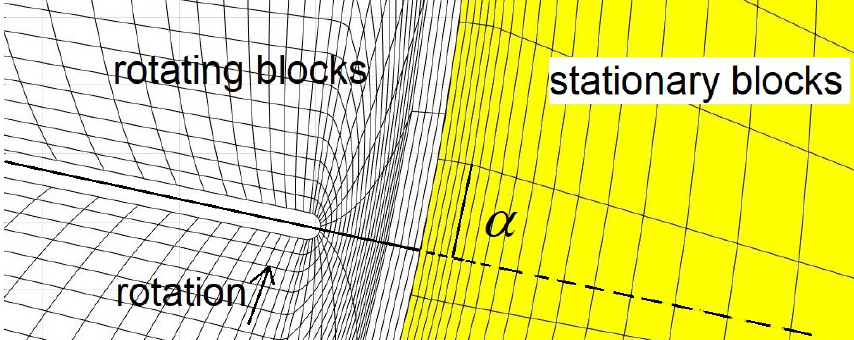
Figure 3. Sketch of the sliding interface, showing the relative displacement angle α between stationary blocks (painted) and rotating blocks